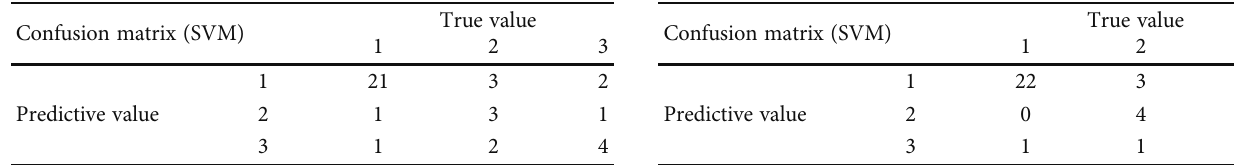
Table 3: Confusion matrix of support vector machine algorithm for predicting ROP grade.